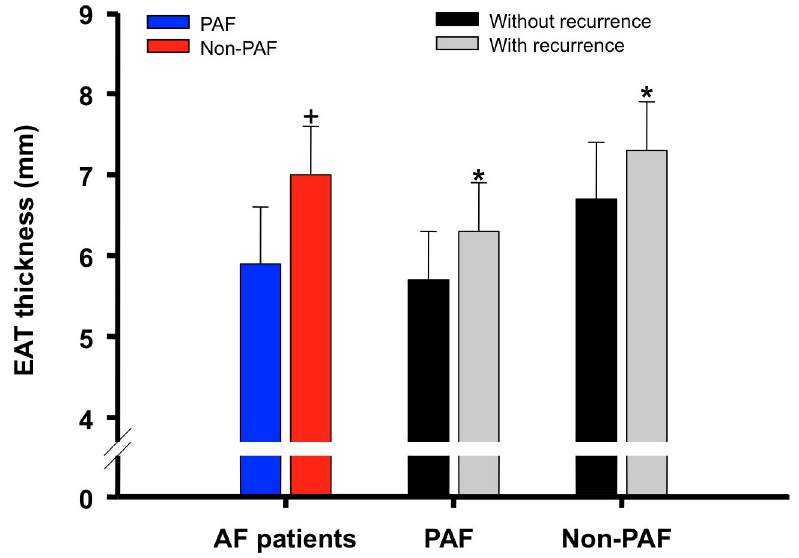
Figure 2. Differences of EAT thickness in PAF and non-PAF patients and those with and without recurrences. Increased EAT thickness was noted among non-PAF patients and those who experienced recurrences after catheter ablation. EAT = epicardial adipoes tissue; PAF = paroxysmal atrial fibrillation. +P value < 0.05, non-PAF versus PAF patients; *P value < 0.05, patients with recurrences versus patients without